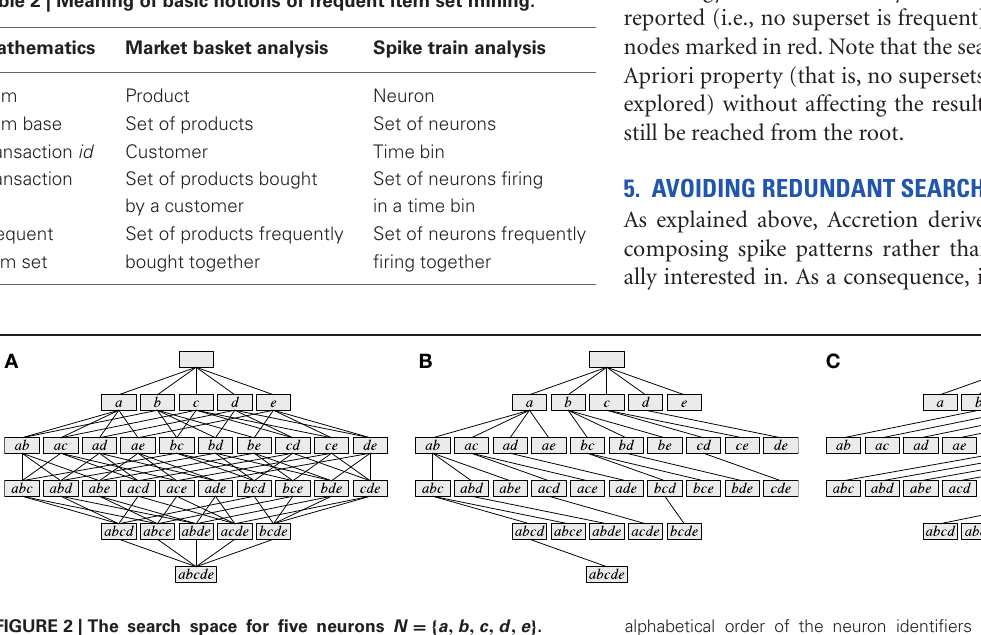
Table 2 | Meaning of basic notions of frequent item set mining.